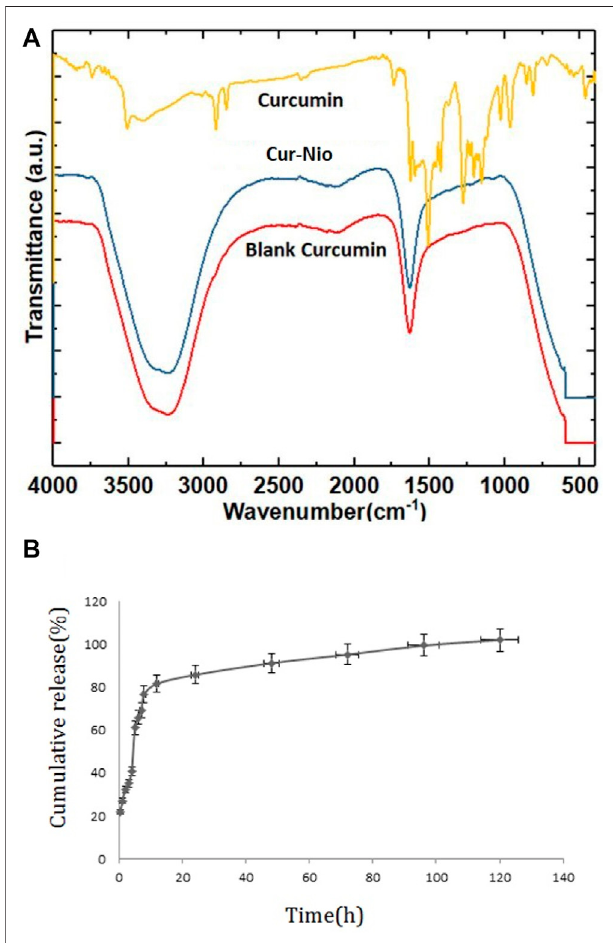
FIGURE 3 | FTIR spectra; a comparison of free curcumin, Cur-Nio, and blank nanoniosome (A) . The in vitro release pro fi le of curcumin from the nanoniosome system (B)